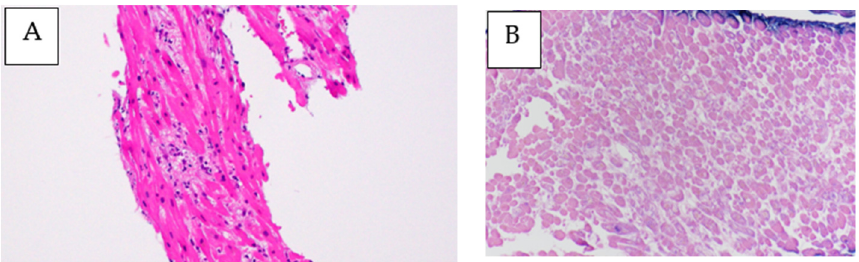
Figure 5. Myocardial biopsy on day 19 of admission. ( A ) Atrophic myocytes with myocardial degeneration and hemorrhage by Hematoxylin and Eosin staining. Fibrosis is not apparent in the interstitium, along with a mild infiltrate of lymphocytes and histiocytes. Magnification ×200; ( B ) Negative Epstein–Barr virus-encoded RNA in situ hybridization (EBER-ISH) analysis. Magnification ×200.